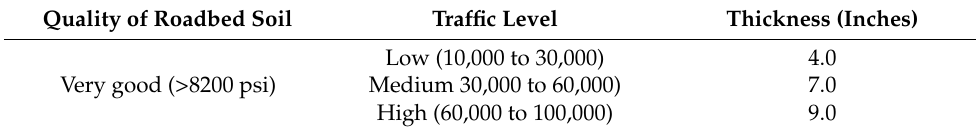
Figure 11. RAP milling surface layer thickness based on E* value for 22%AV (a 1 = 0.18). Table 8. Recommended RAP millings surface layer thickness if considered unbound.